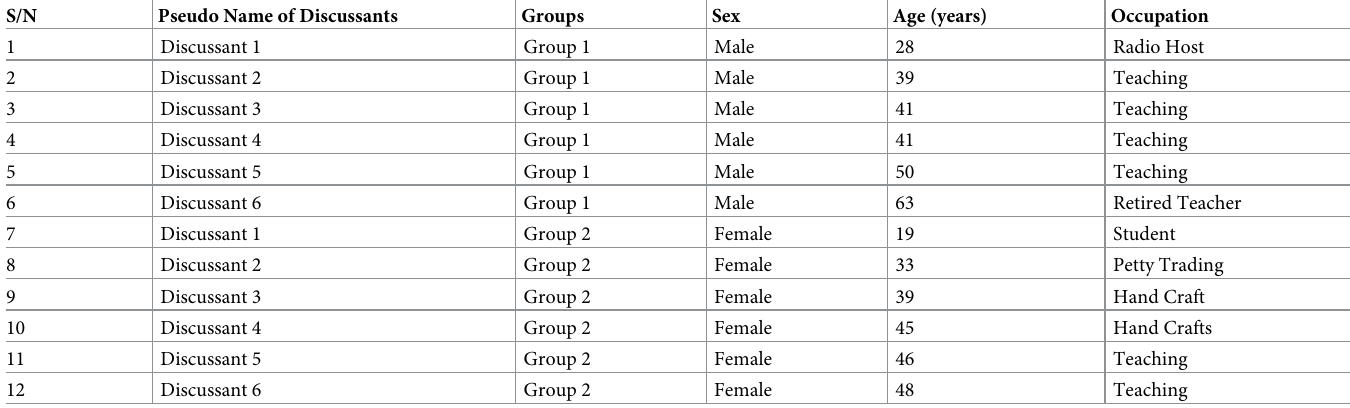
Table 2. Metadata of members of focus group